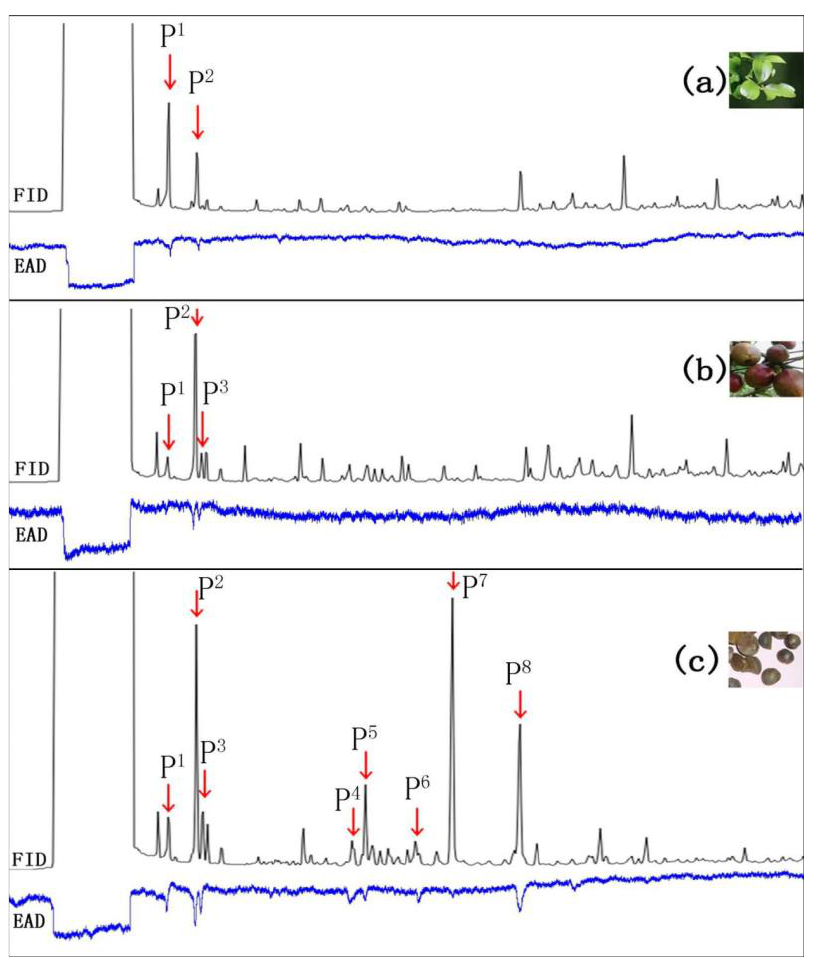
Figure 3. GC-EAD analysis of volatiles from Camellia oleifera leaves ( a ), fruits ( b ), and seeds ( c ) to the antennae of Curculio chinensis, indicating that a total of eight peaks was electrophysiologically active compounds. P1-8 were 3-hexenal, trans -2-hexenal, trans -2-hexen-1-ol, 2-ethyl-1-hexanol, phenethyl alcohol, methyl salicylate, geraniol, and eugenol, respectively.